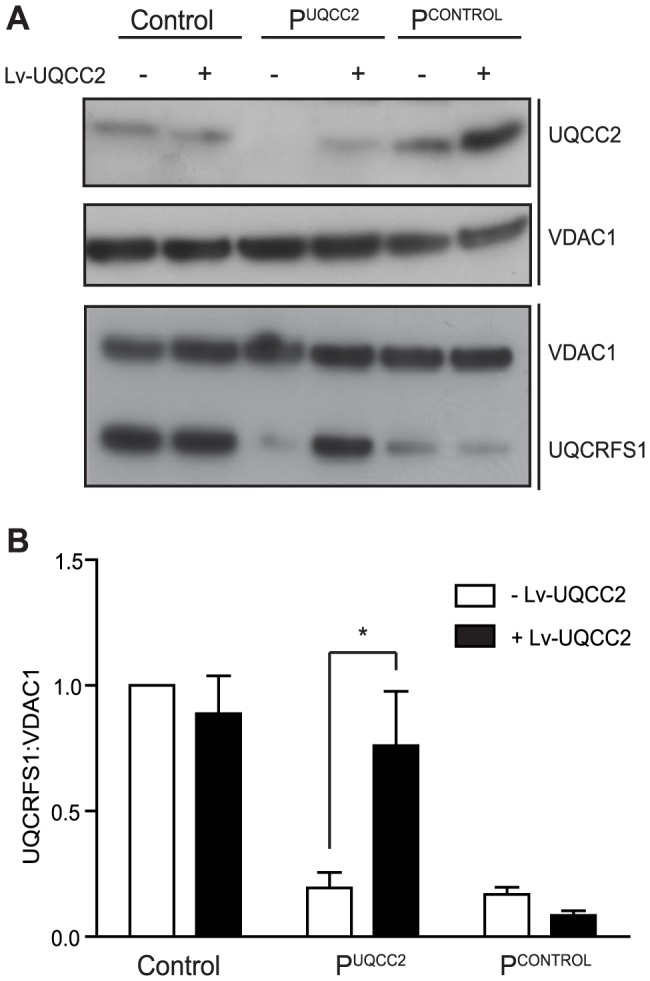

UQCC2 mutations are responsible for the complex III defect in PUQCC2.Fibroblasts from Control, PUQCC2 with mutations in UQCC2 and PCONTROL with mutations in a complex III subunit gene (and no UQCC2 mutation) were transduced with wild-type UQCC2 mRNA. (A) Representative SDS-PAGE western blot shows reduced UQCC2 in PUQCC2 and increased UQCC2 expression following UQCC2 transduction. VDAC1 acts as a loading control. UQCRFS1 protein is reduced in both complex III deficient patients and restored in PUQCC2, but not PCONTROL, with UQCC2 transduction. VDAC1 acts as a loading control. (B) The intensity of immunostained UQCRFS1 relative to VDAC1 before and after transduction with UQCC2 was quantified by densitometry. Error bars indicate 1 s.e.m. for 3 independent transductions and the asterisk indicates p<0.05, two way ANOVA.